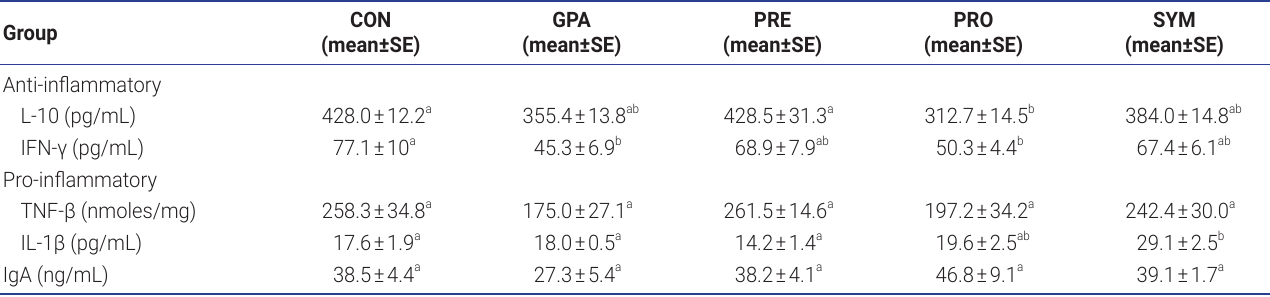
IgA (ng/mL) CON, control; GPA, with growth-promoting antibiotic; PRE, with agave fructan capsules; PRO, with Bifidobacterium animalis capsules; SYM, with symbiotic capsules; SE, standard error; IL-10, interleukin 10; IFN-γ, gamma interferon; TNF-β, tumor necrosis factor beta; IL-1β, interleukin 1 beta; IgA, immunoglobu - lin A; ng, nanogram; Ml, milliliter; pg, picogram; mg, milligram; nmoles, nanomoles. a,b Different letters indicate significant differences between groups